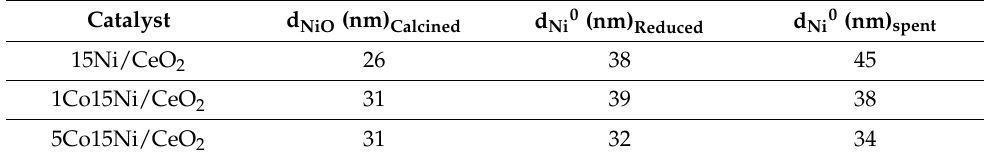
Figure 3. X-ray diffractograms of the studied catalysts. Table 4. NiO and Ni 0 crystallite sizes after calcination, reduction and reaction determined applying Scherrer equation.